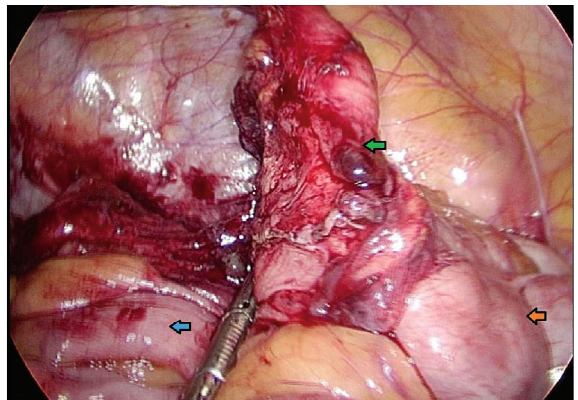
Figure 4: Laparoscopic view of the stump (green arrow), cecum (orange arrow), and terminal ileum (blue arrow).